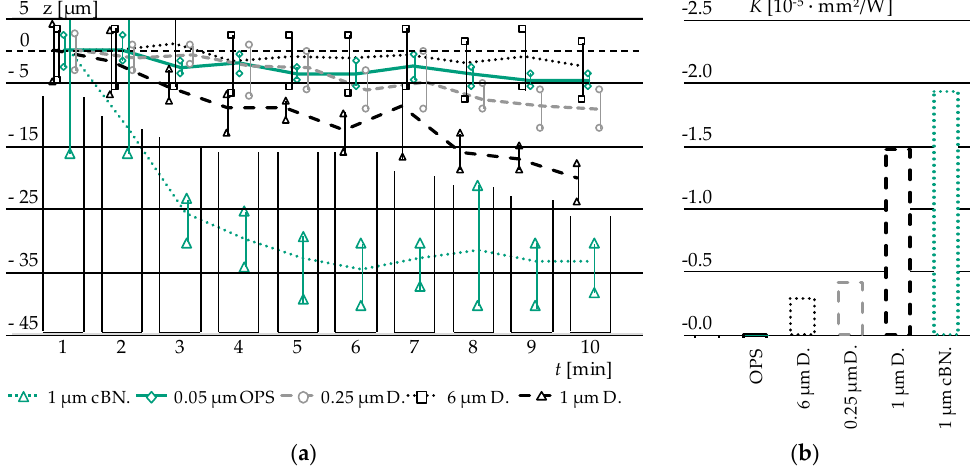
Figure 8. ( a ) Comparison of different polishing abrasives and their material removal expressed as height reduction over time; ( b ) Evaluation of K -Factor for different abrasives.